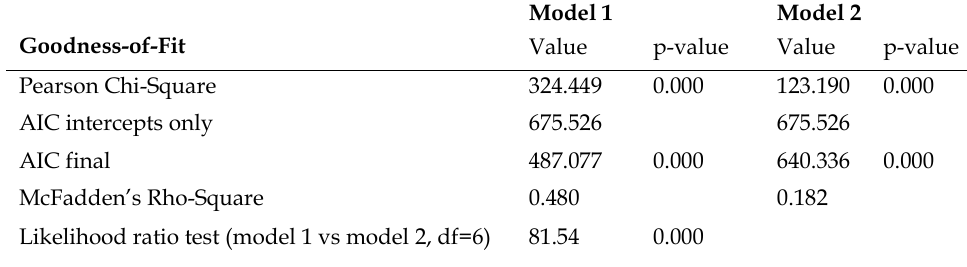
Table 4. Goodness-of-Fit Model 1 and Model